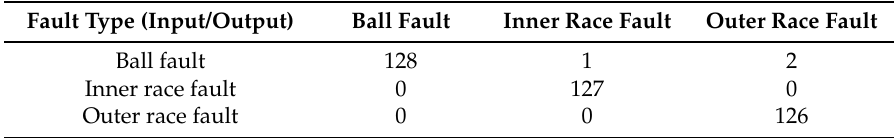
Table 2. Confusion matrix, segments of the design set.